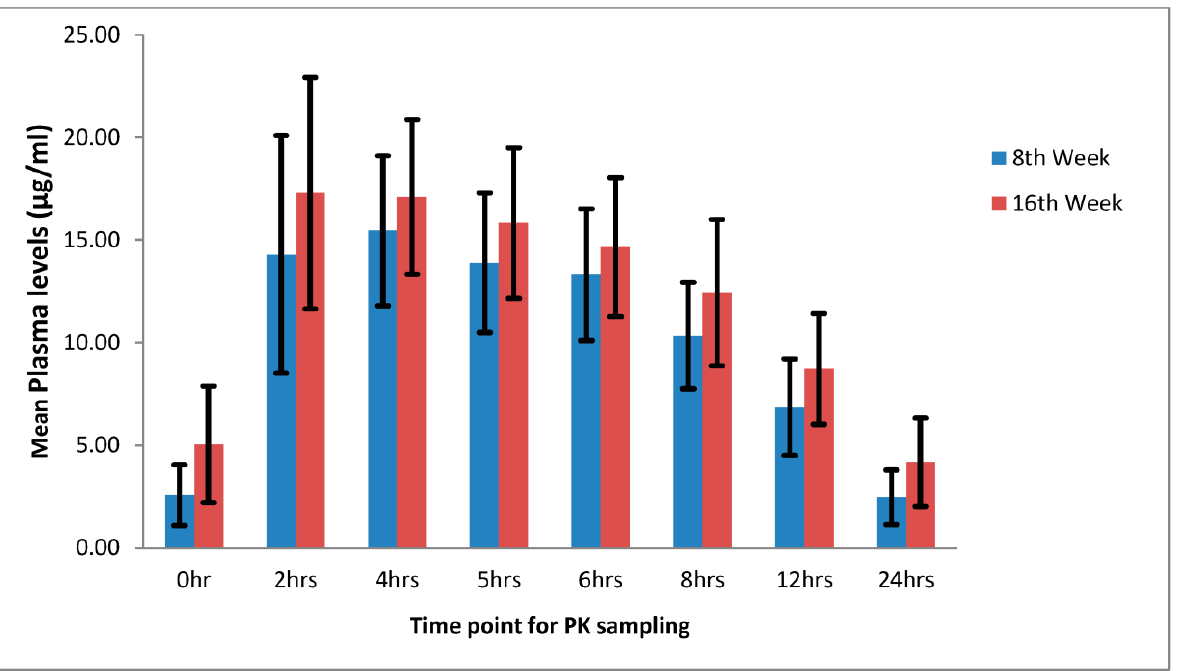
Figure 1. Mean plasma concentration of linezolid (with 95% CI) at different time points in study participants on a linezolid-containing regimen for treatment of drug-resistant tuberculosis. Table 1. Demographic and pharmacokinetic parameters of participants who underwent intense pharmacokinetic testing for tablet linezolid.